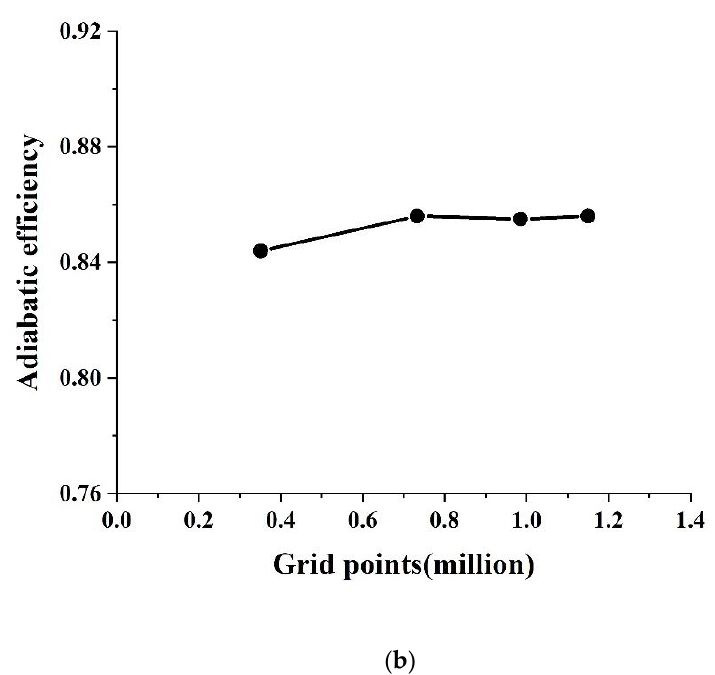
Figure 7. Mesh independence verification. ( a ) Mass flow rate and ( b ) Adiabatic efficiency.